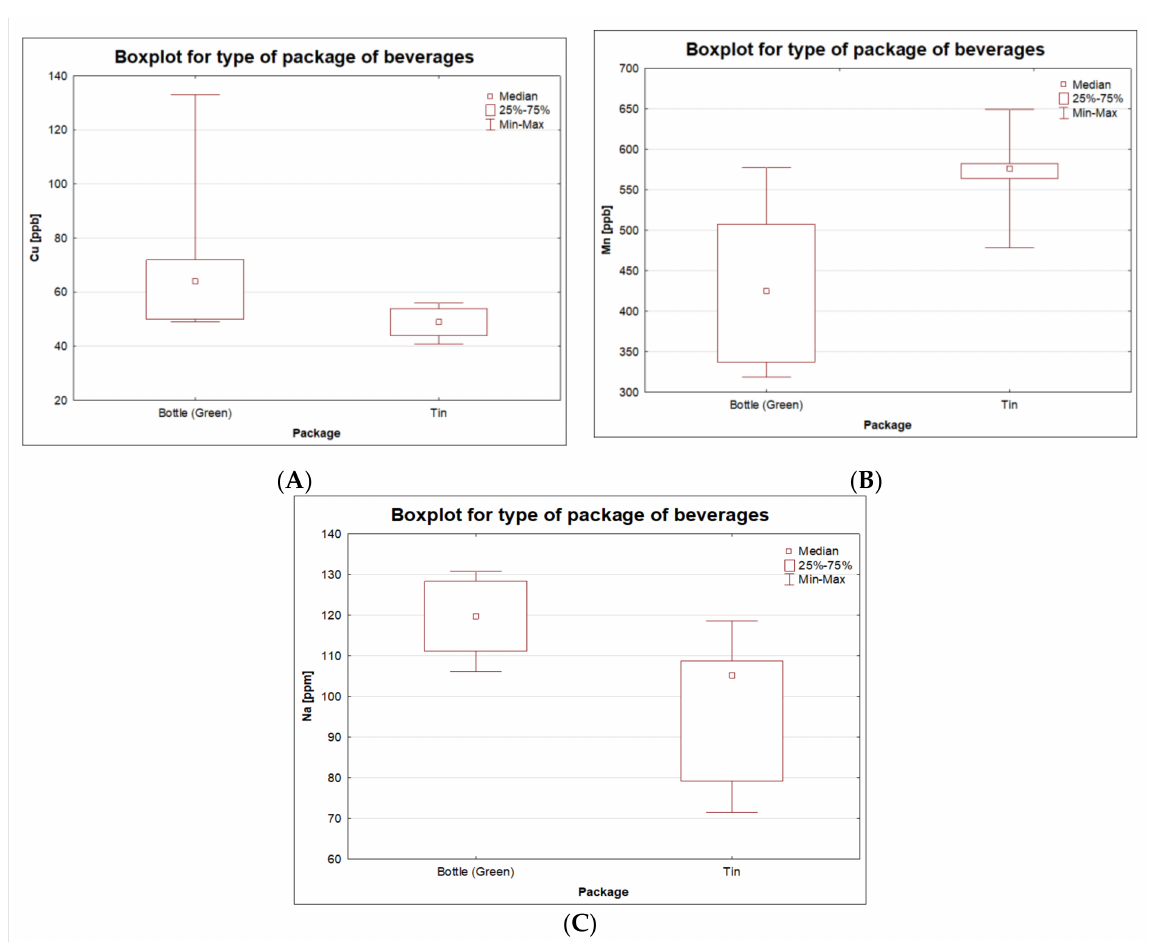
Figure 1. Boxplot for contents of Cu ( A ), Mn ( B ) and Na ( C ) for obtained results of 12 samples of one brand of cider divided according to type of